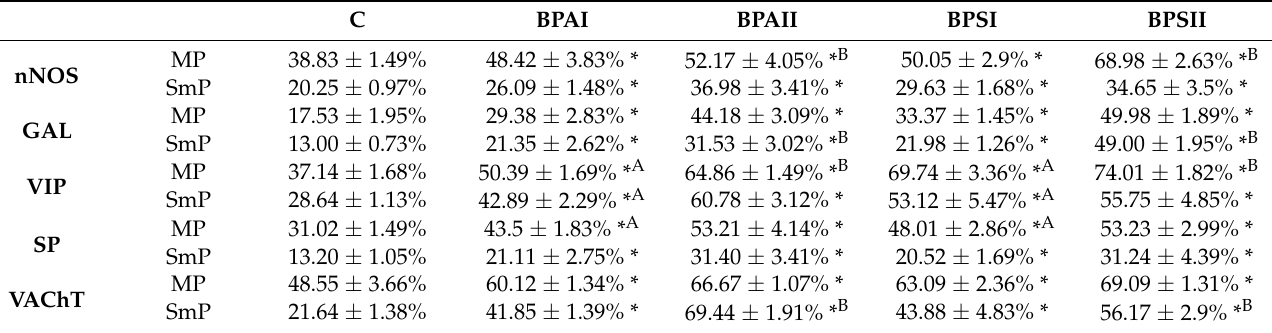
VAChT 21.64 ± 1.38% 41.85 ± 1.39% * 69.44 ± 1.91% * B 43.88 ± 4.83% * 56.17 ± 2.9% * B Statistically significant ( p ≤ 0.05) differences between C group and every experimental group are marked with *; Statistically significant differences between BPAI and BPSI group are marked with A ; Statistically significant differences between BPAII and BPSII groups are marked with B